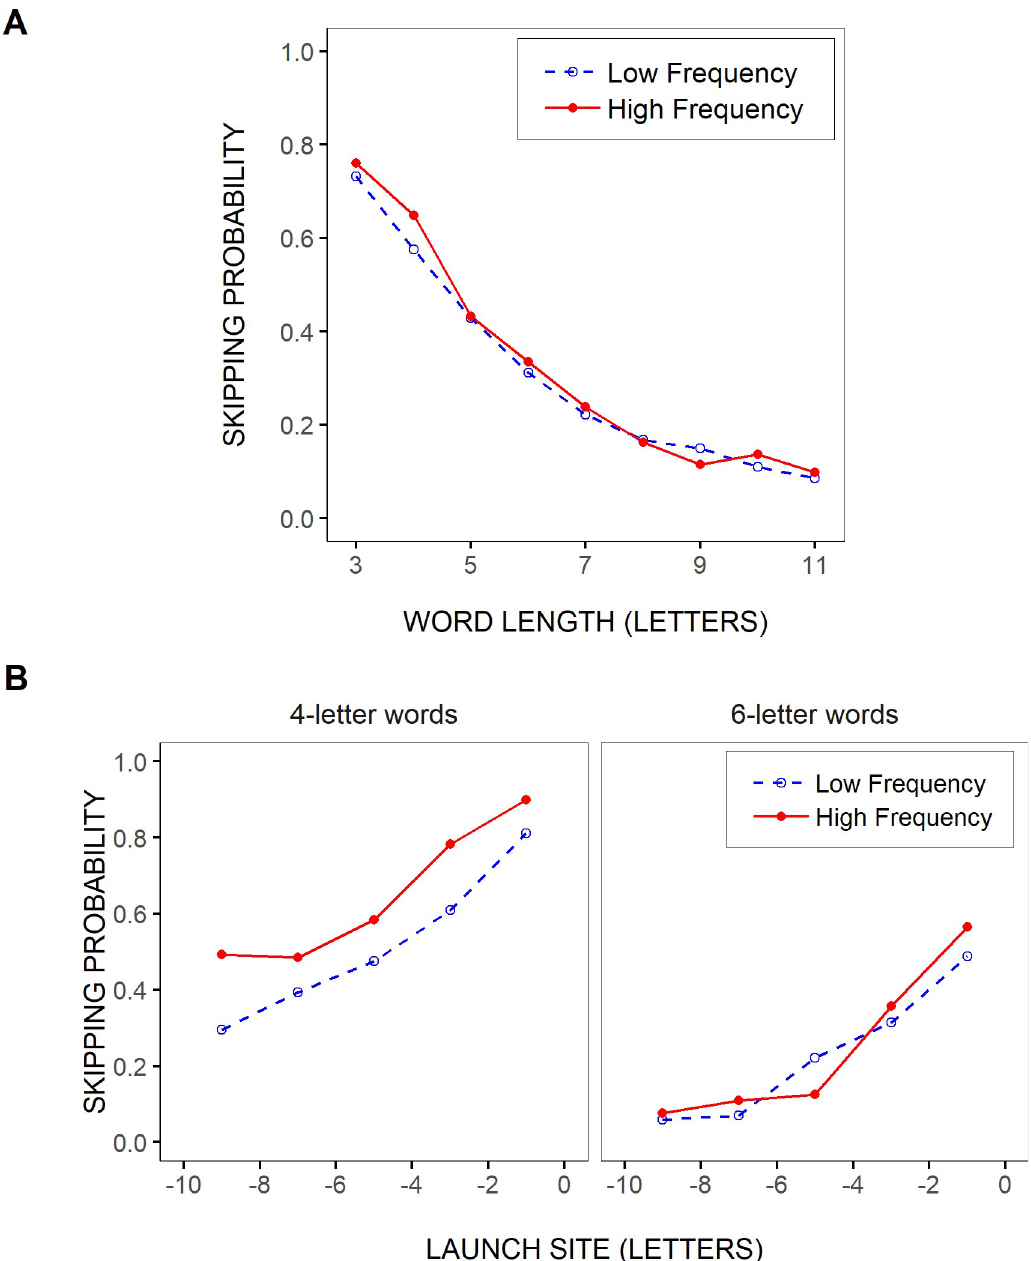
Fig 5. Word-skipping rate by length, launch site and frequency. Mean probability of word skipping, across all words in the sentences that responded to our selection criteria, as a function of word length (in letters; A), and for 4- and 6-letter words as a function of saccadic launch-site distance (in letters relative to the space in front of the words; B), separately for two categories of word frequencies, as determined after grouping word frequencies into two bins (see Materials and Methods).